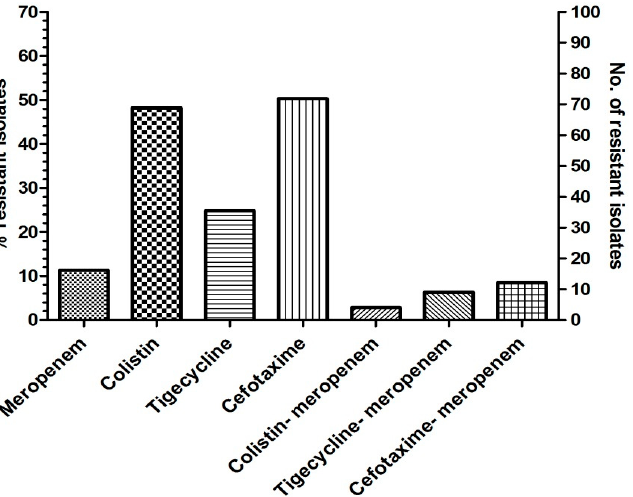
Figure 1. The distribution of antibiotic-resistant isolates among the Gram-negative bacterial isolates. A total of 141 Gram-negative bacteria were investigated in this study.